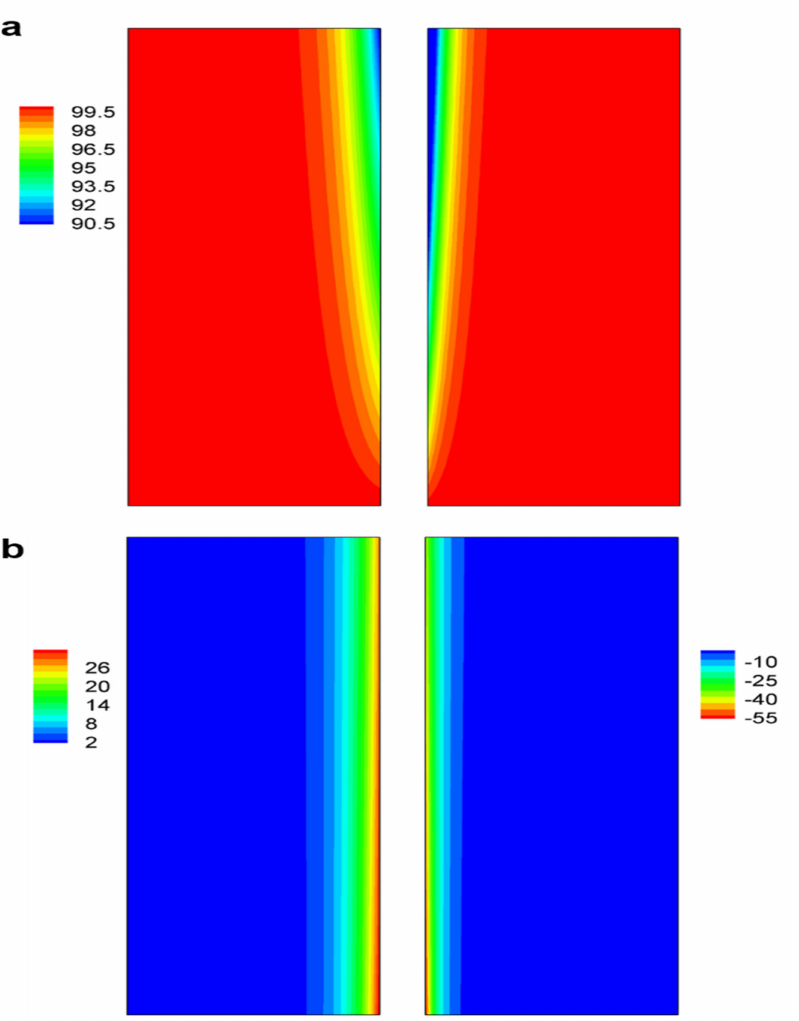
Figure 4. ( a ) Concentration distribution of V(II) at negative side and V(IV) at positive side and ( b ) reaction current density distribution at SOC of 50% during discharging at 10 mA cm − 2 . Flow rate: 25 mL min − 1 ; temperature: 300